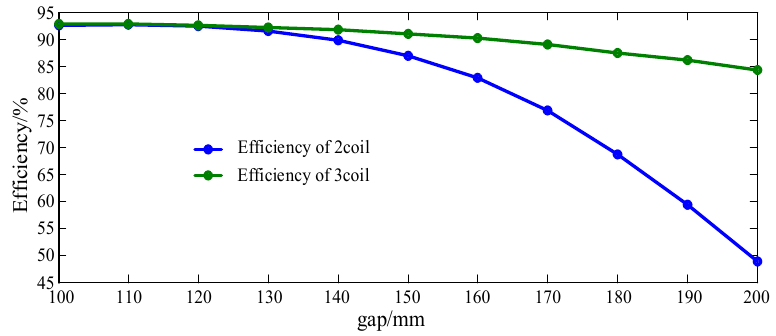
Figure 13. Mutual-inductance Versus Transfer Distance.